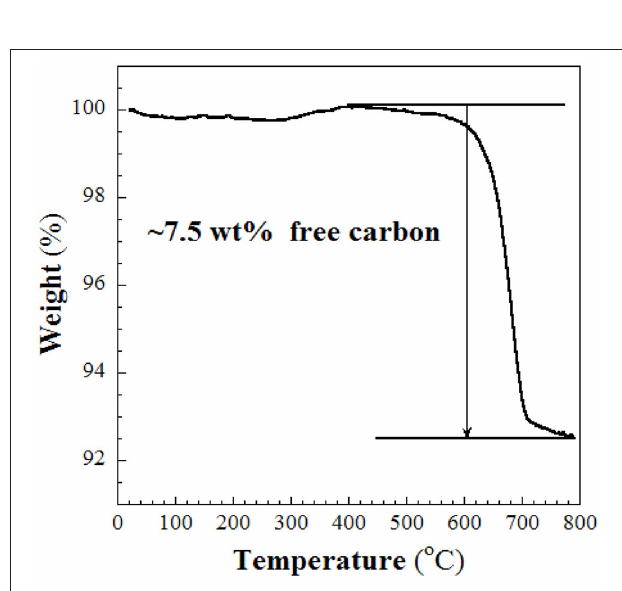
FIGURE 2 | TGA curve of the sample S2